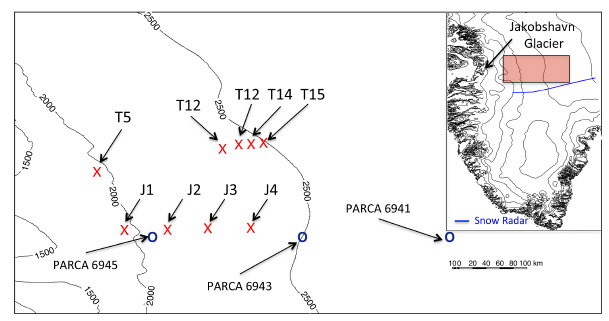
Figure 1. Location of research area and research sites (all T-sites are along the EGIG line). Inset: map of western Greenland showing the area surveyed. Blue line is the flight path of the NASA Operation IceBridge data shown in Figs. 4 and 5. Snowpit sites are shown with an X, while core sites are shown with a blue circle. Contour lines represent 500m surface elevation